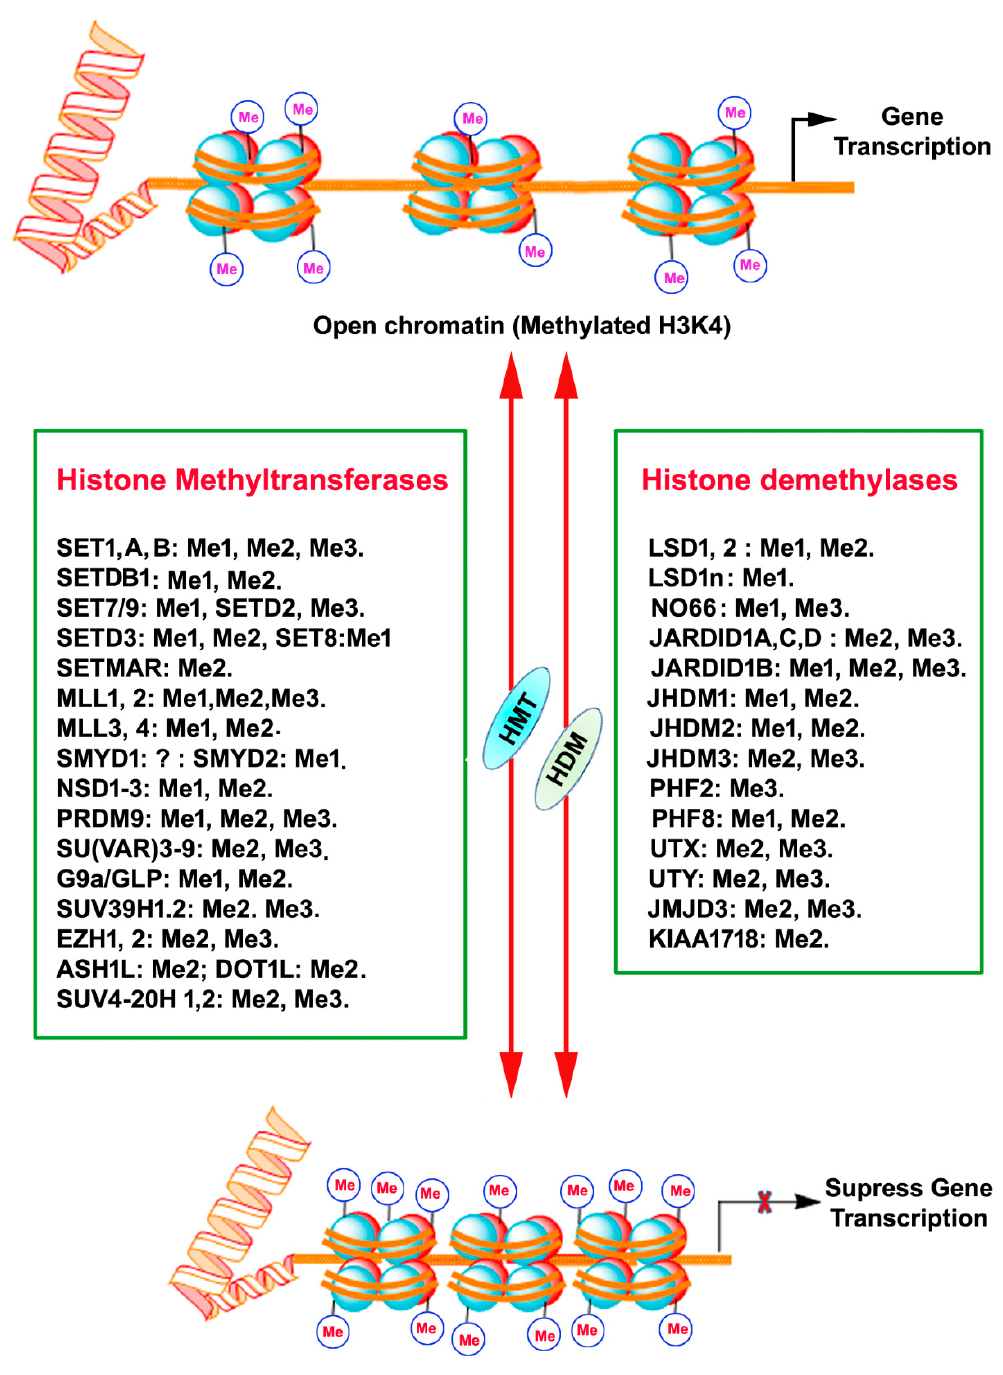
Figure 1. A schematic depiction of chromatin histone protein lysine methylation and demethylation by the mammalian histone methyltransferase (KMTs) and histone demethylase (KDMs) enzyme families. The HMT and HDM for each lysine methylation are also represented with their methylation/demethylation state specificities (Me1, monomethylation; Me2, dimethylation; Me3, trimethylation), X, inhibition.